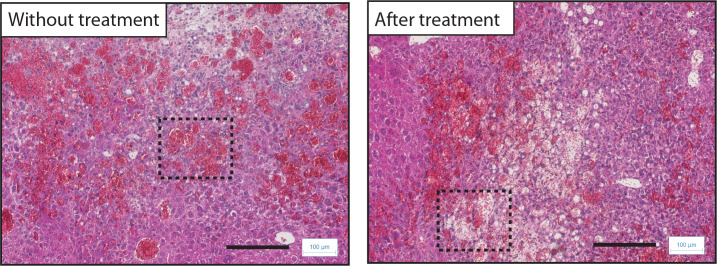
Anti-EPO blocking serum treatment in [Apc-Arid1a]ko-focal mice leads to decrease of intra-hepatic red blood cells accumulation.Hematoxylin Eosin (HE)-stained sections of livers from untreated and treated 7-month-old [Apc-Arid1a]ko-focal mice with anti-EPO blocking serum. Scale bars = 200 μm. The dotted outlines correspond to increasing magnification showed in Figure 4f.